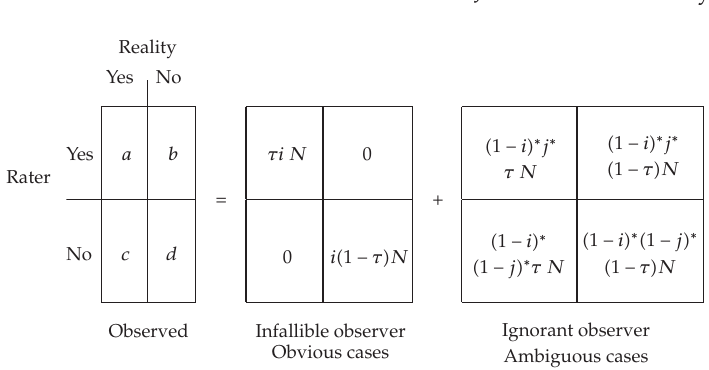
Figure 1: Gold standard data generating